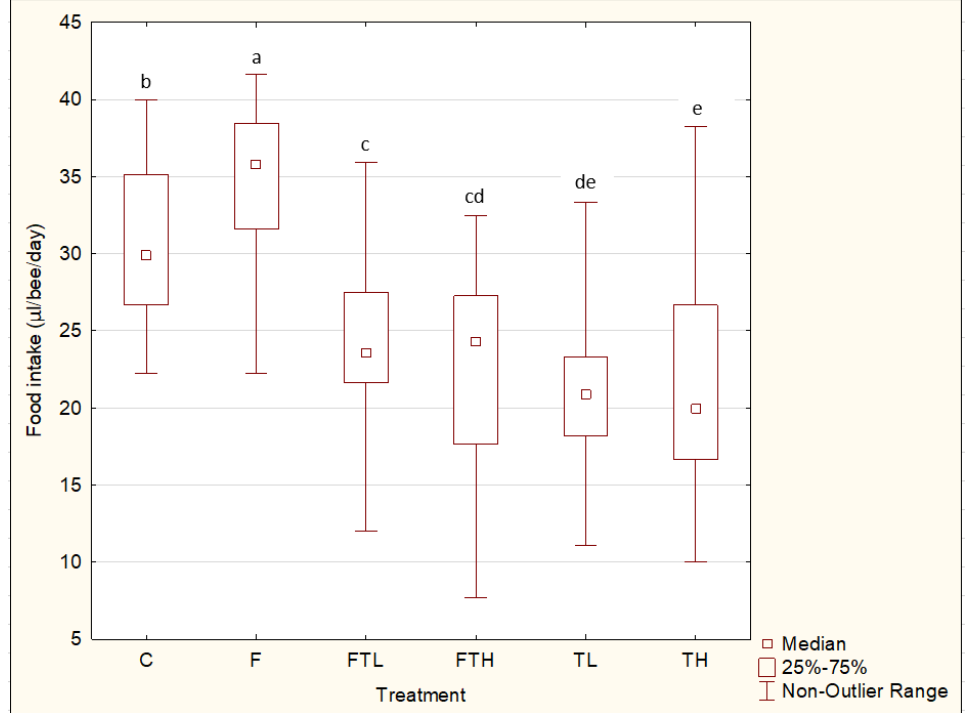
Figure 2. The daily average of the food intake per 1 bee over 14 days. Significant differences ( p < 0.05) in food consumption between treatments are indicated by different letters.